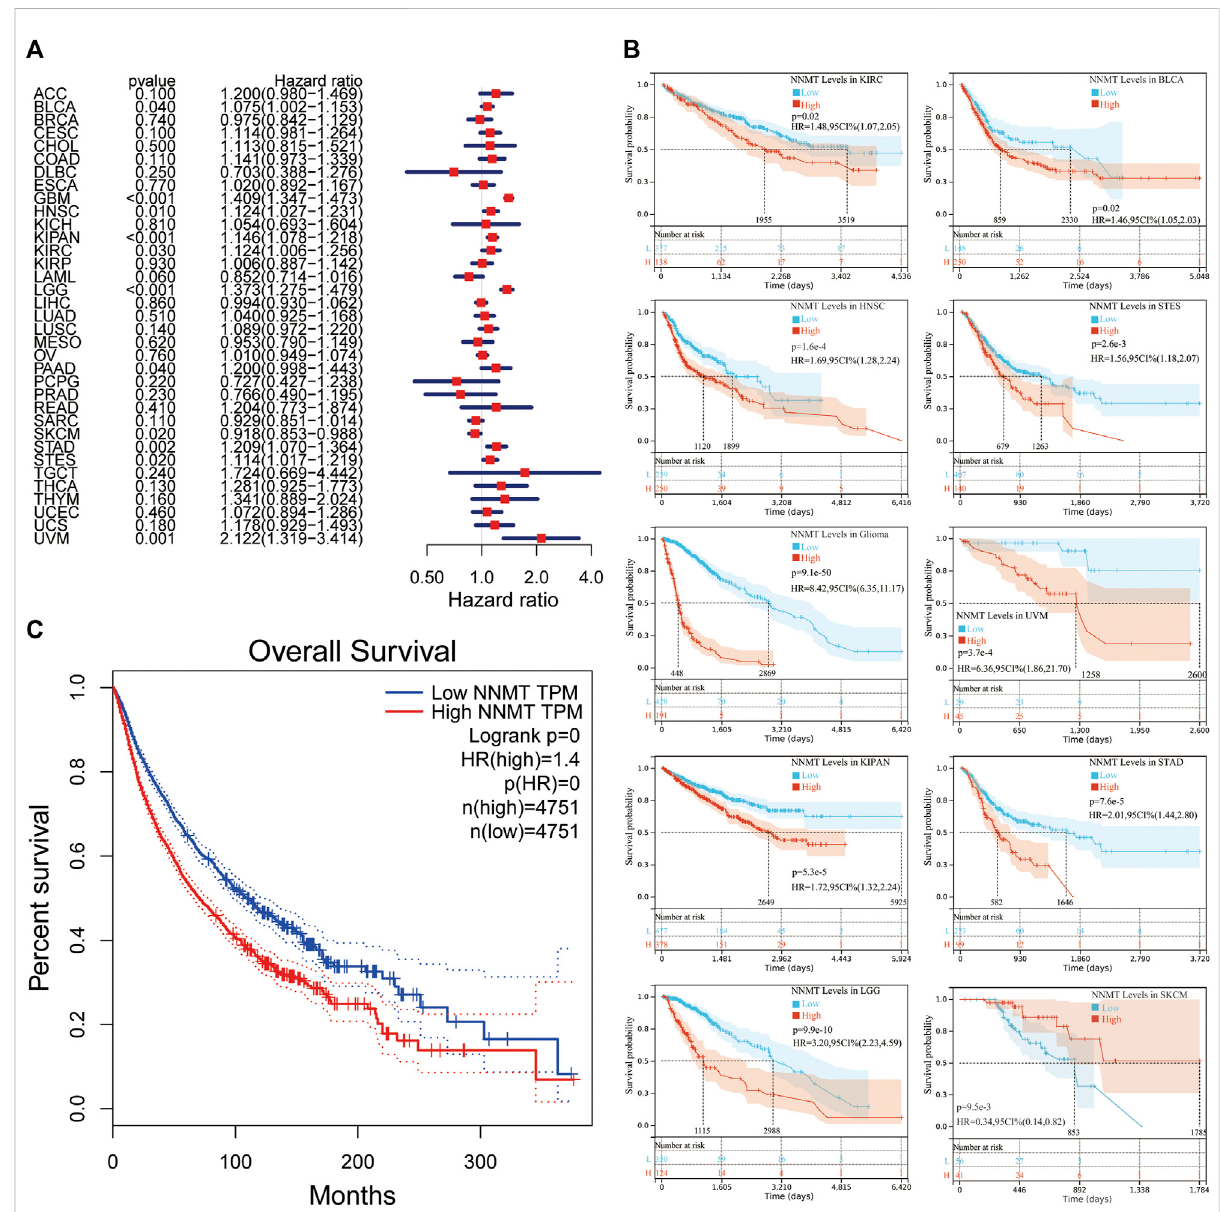
FIGURE 4 TherelationshipbetweenNNMTexpressionandoverallsurvivaltimeindays(OS). (A) CoxregressionevaluationofcorrelationsbetweenOSand 33categoriesoftumorsusingasinglevariable. (B) UsingdatafromtheTCGAdatabase,ahighNNMTexpressionlevelwasrelatedwithashorterOSas compared to a low expression in 10 cancer types. (C) The Kaplan-Meier median expression value analysis between NNMT transcription and OS in 33 different